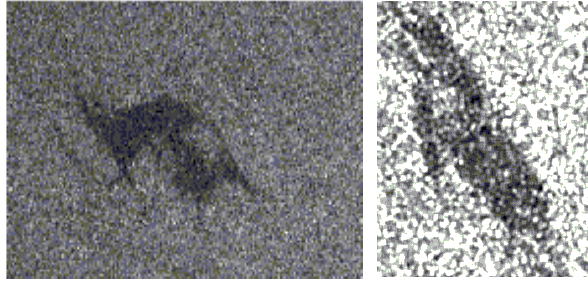
Figure 2. Objects from ALOS PALSAR (left) and RADARSAT-2